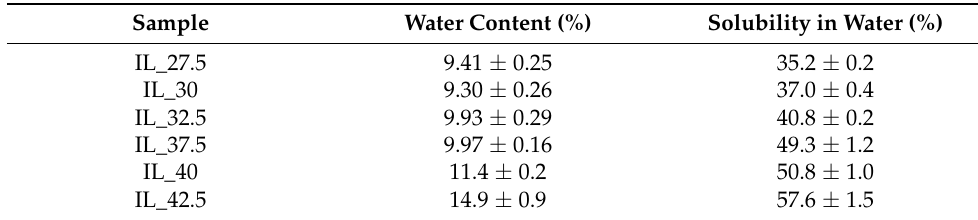
Table 1. Hydration properties of the sheets studied.